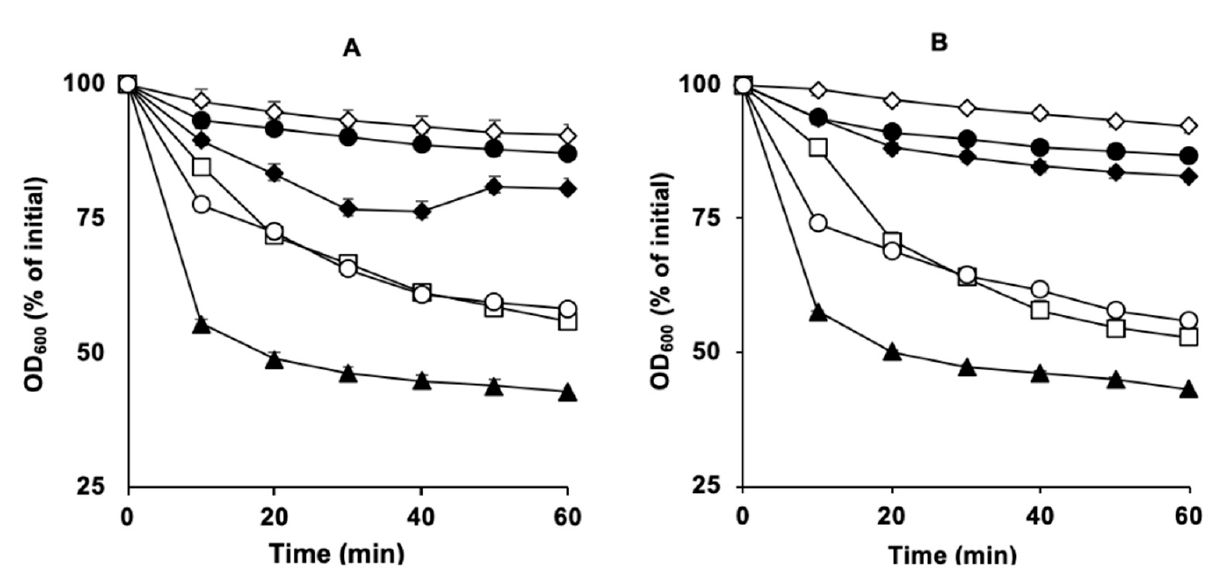
Figure 5. Germination of C. perfringens SM101 spores in the presence of MgCl 2 , MnCl 2 , and a general metal ion chelator (EDTA). Heat-activated spores were incubated for 60 min at 37 °C with 50 mM Tris HCl buffer at pH 6.0 supplemented with either ( A ) 100 mM KCl (filled triangles), 50 mM EDTA + 100 mM KCl (open circles), 50 mM MgCl 2 (open squares), 50 mM EDTA-MgCl 2 + 100 mM KCl (filled diamonds), 50 mM MgCl 2 -EDTA (open diamonds), or 25 mM Tris HCl buffer (filled circles); or ( B ) 100 mM KCl (filled triangles), 50 mM EDTA + 100 mM KCl (open circles), 50 mM MnCl 2 (open squares), 50 mM EDTA-MnCl 2 + 100 mM KCl (filled diamonds), 50 mM MnCl 2 -EDTA (open diamonds), or 25 mM Tris HCl buffer (filled circles). The changes in the OD 600 were used to calculate the percent germination. Error bars are the standard deviations from the means of at least duplicate experiments with two independent spore preparations.